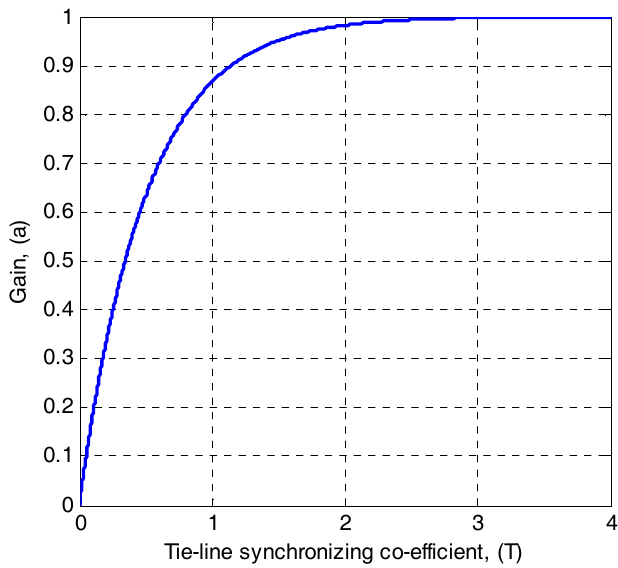
Figure 10. Relation between tie-line synchronizing coefficient ( T ) and new introduced gain (a).